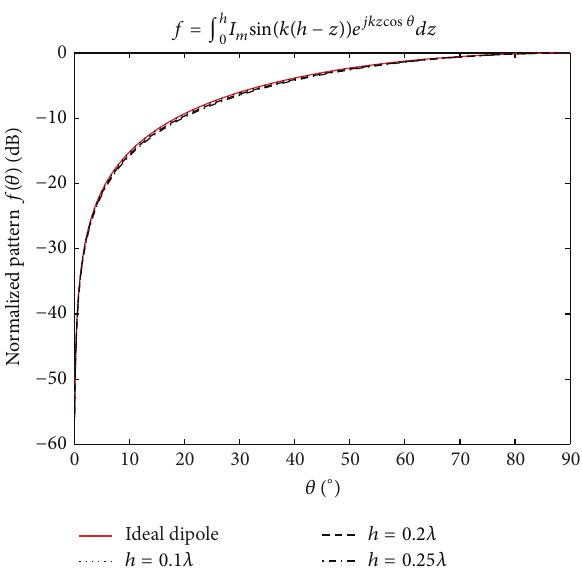
Figure2:Radiationpatternsof 0.1𝜆 , 0.2𝜆 ,and 0.25𝜆 monopolesand of ideal dipole.